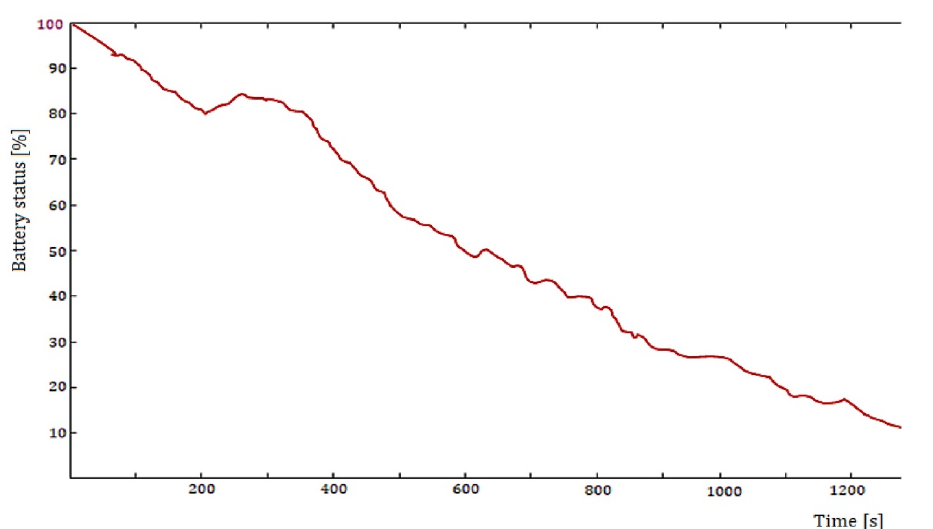
Figure 10. Simulated electric car test drive.